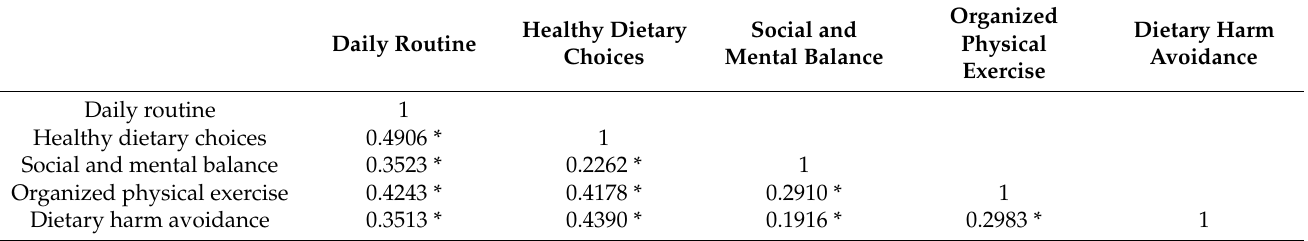
Table 4. Correlations (Pearson ´ s rho) between HLPCQ